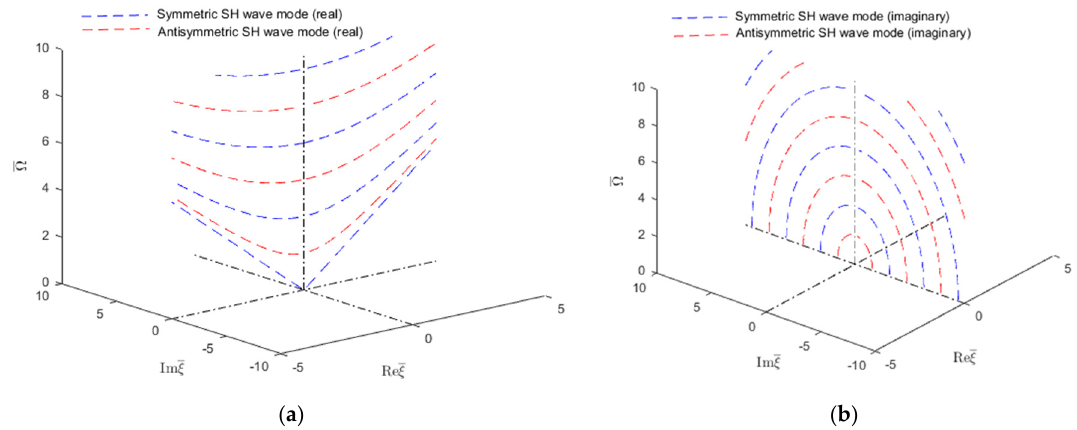
Figure 6. Real and imaginary SH wavenumber trajectories in an isotropic aluminum alloy plate as